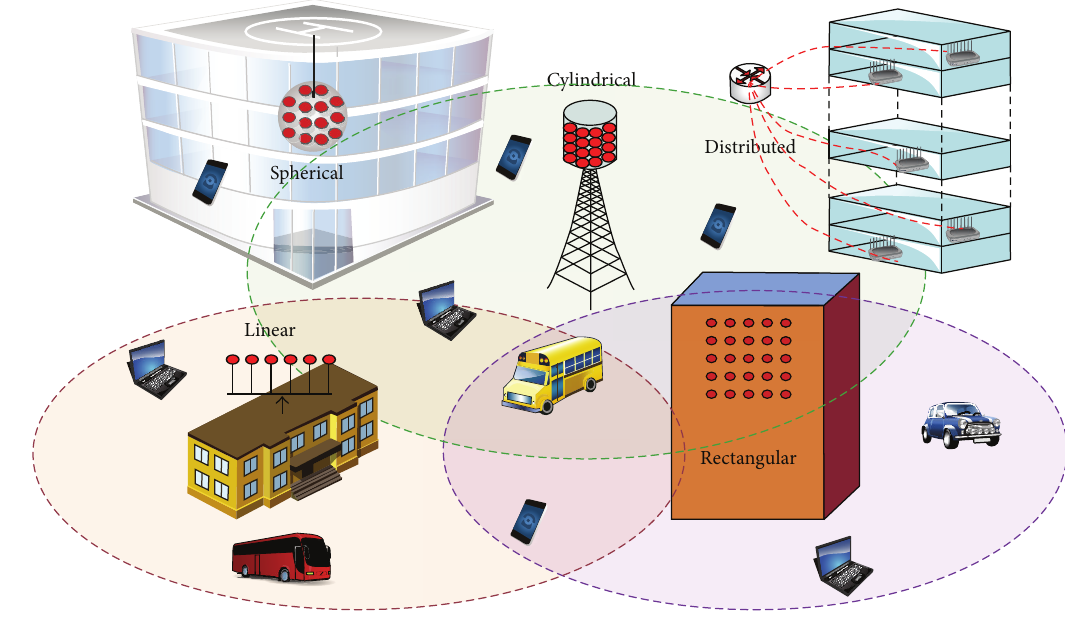
Figure 1: Antenna array configuration